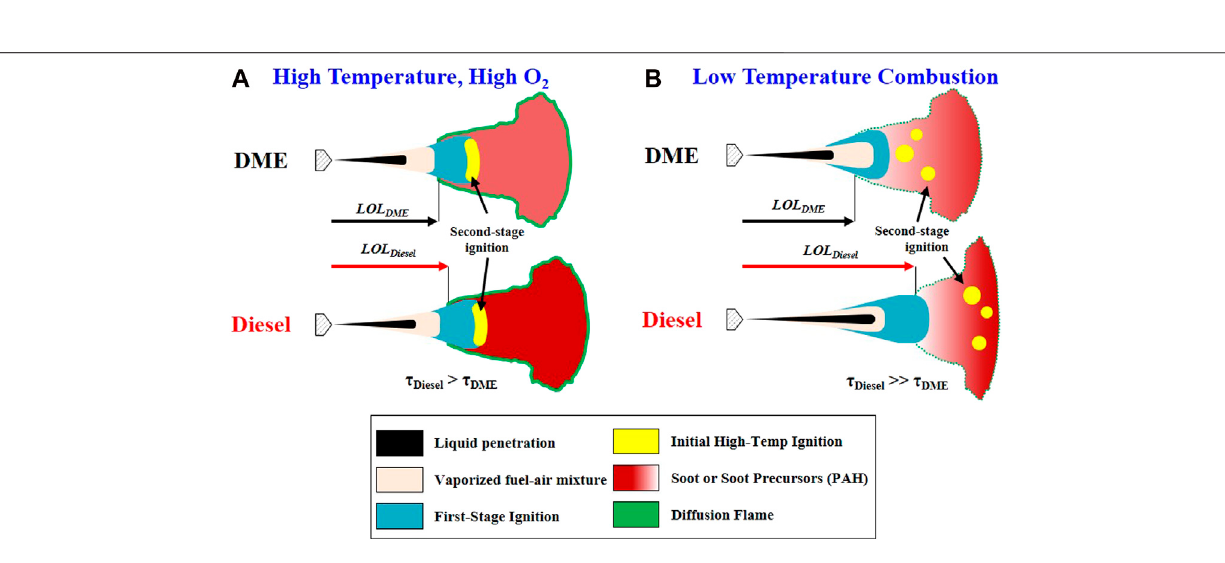
Frontiers in Mechanical Engineering |